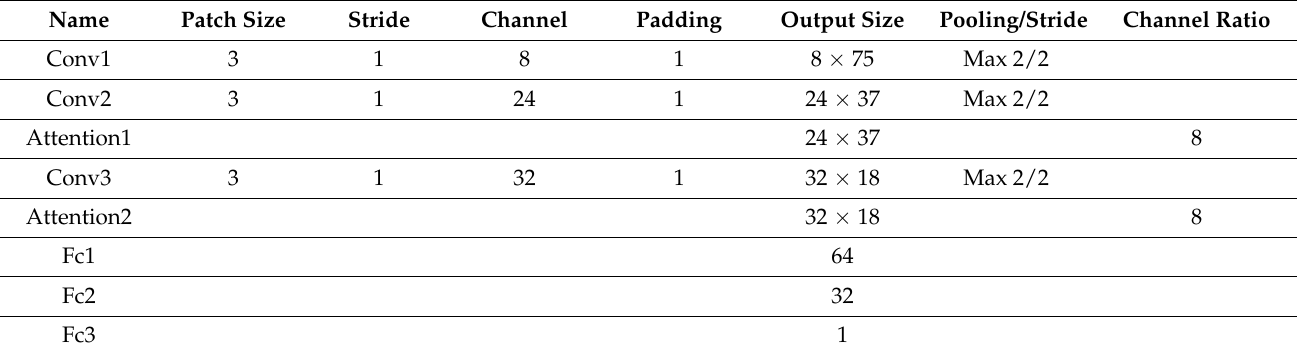
Table 2. The structure of our proposed 1DCNN for water quality parameter